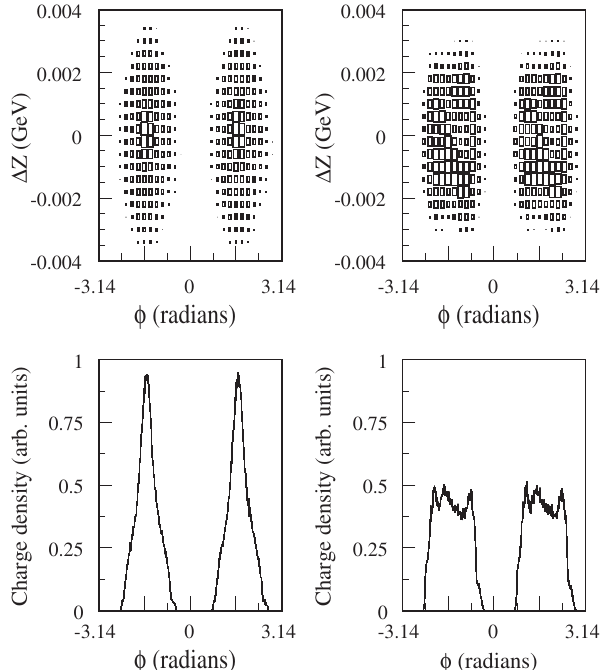
FIG. 6. Simulated longitudinal phase space distributions and their projections onto the longitudinal axis of the circulating beam at the end of injection obtained without (left) and with (right) longitudinal injection painting.